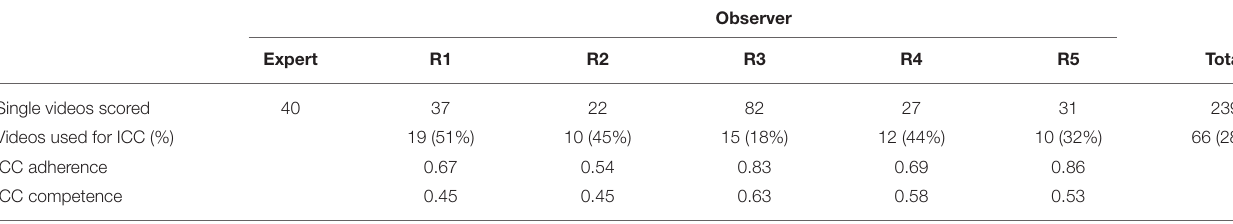
TABLE 1 | Distribution of videos per observer (single scored and